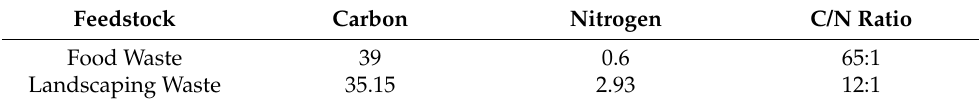
Table 1. Initial characterization of